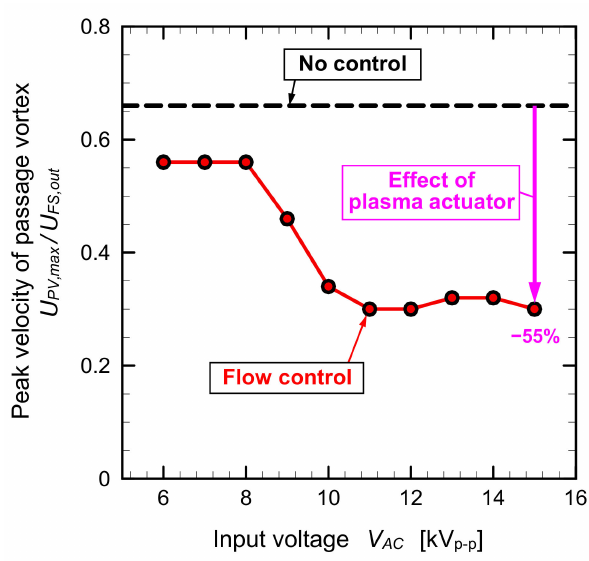
Figure 12. Peak velocity of passage vortex in center passage ( U FS , out = 2.4 m /